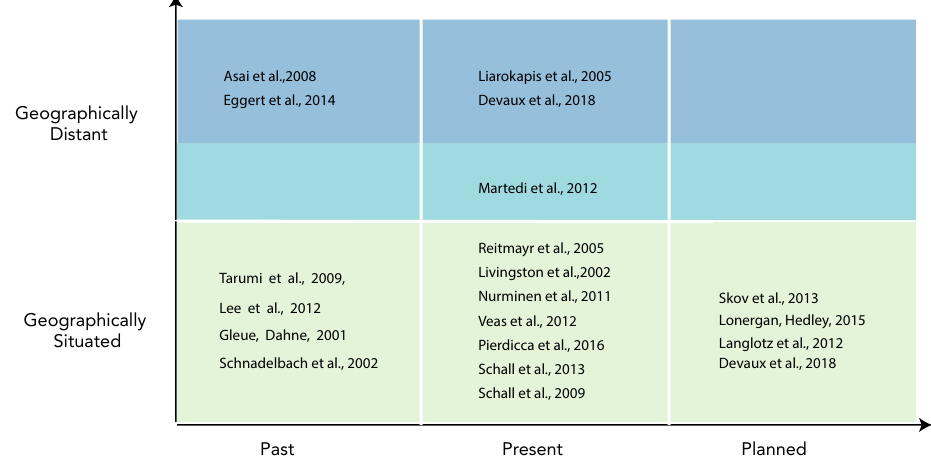
Figure 2. Papers presenting a visualization of physical data using AR organized by geographical indirection and temporal